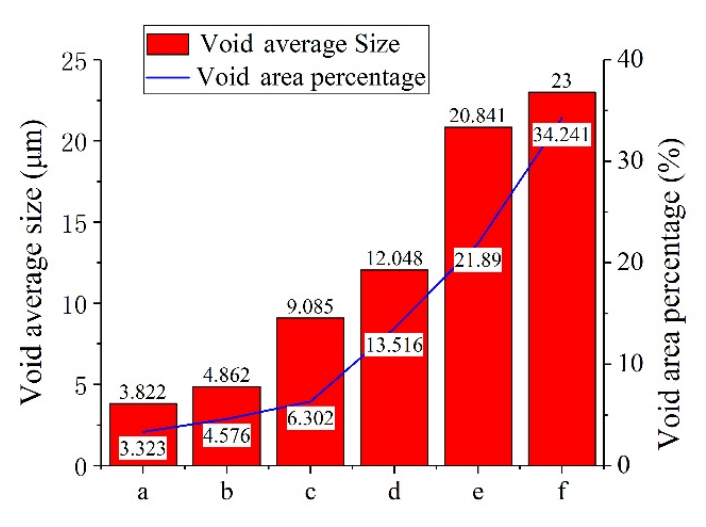
Figure 7. Void statistics. (a—400 W 200 min, b—400 W 300 min, c—1200 W 120 s, d—1200 W 240 s, e—2000 W 80 s, f—2000 W 120 s).